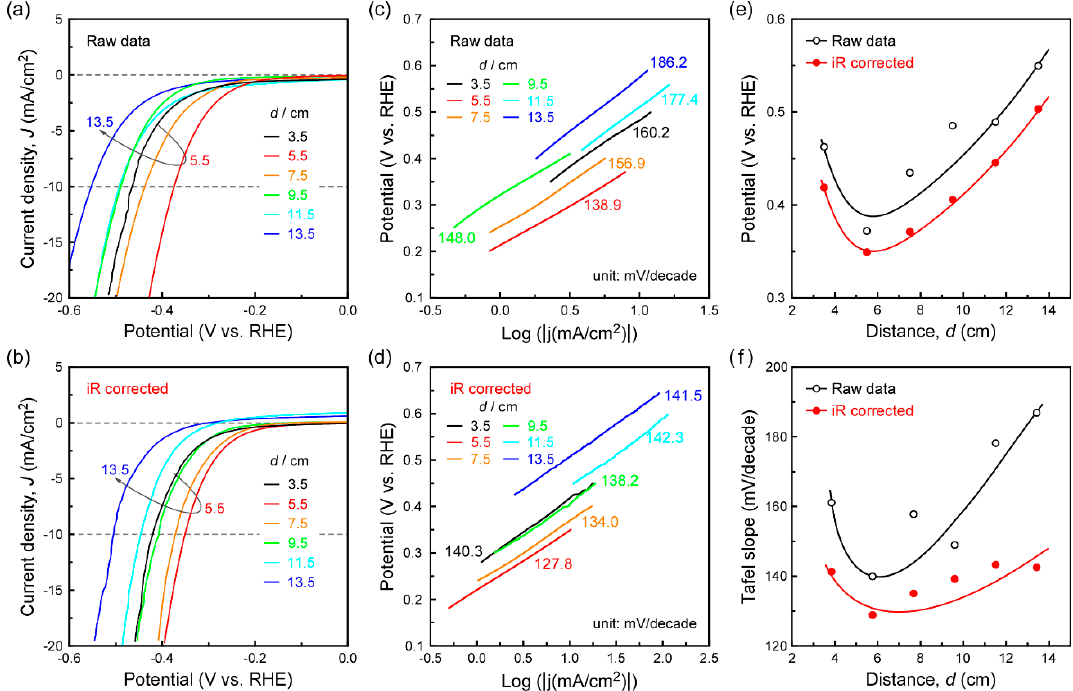
Figure 5. Electrochemical characterization of vertically standing MoS 2 nanosheets grown on Au foils at different d . Polarization curves of raw data ( a ) and iR-corrected data ( b ); corresponding Tafel plots of raw data ( c ) and iR-corrected data ( d ); potential value to achieve − 10 mA/cm 2 ( e ) and Tafel slope ( f ) at different d .